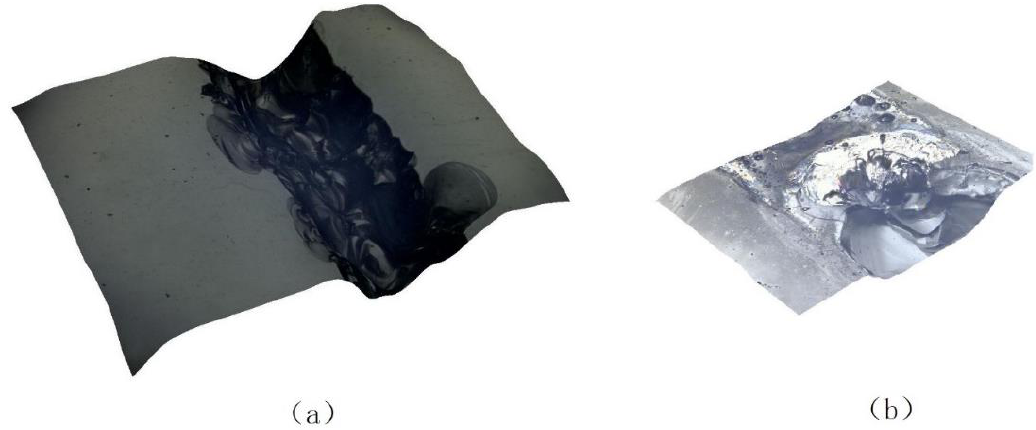
Figure 8. Micrographs of titanium alloy and high borosilicate glass using laser voltage for transmission welding of 480 V: ( a ) glass and ( b ) titanium alloy.